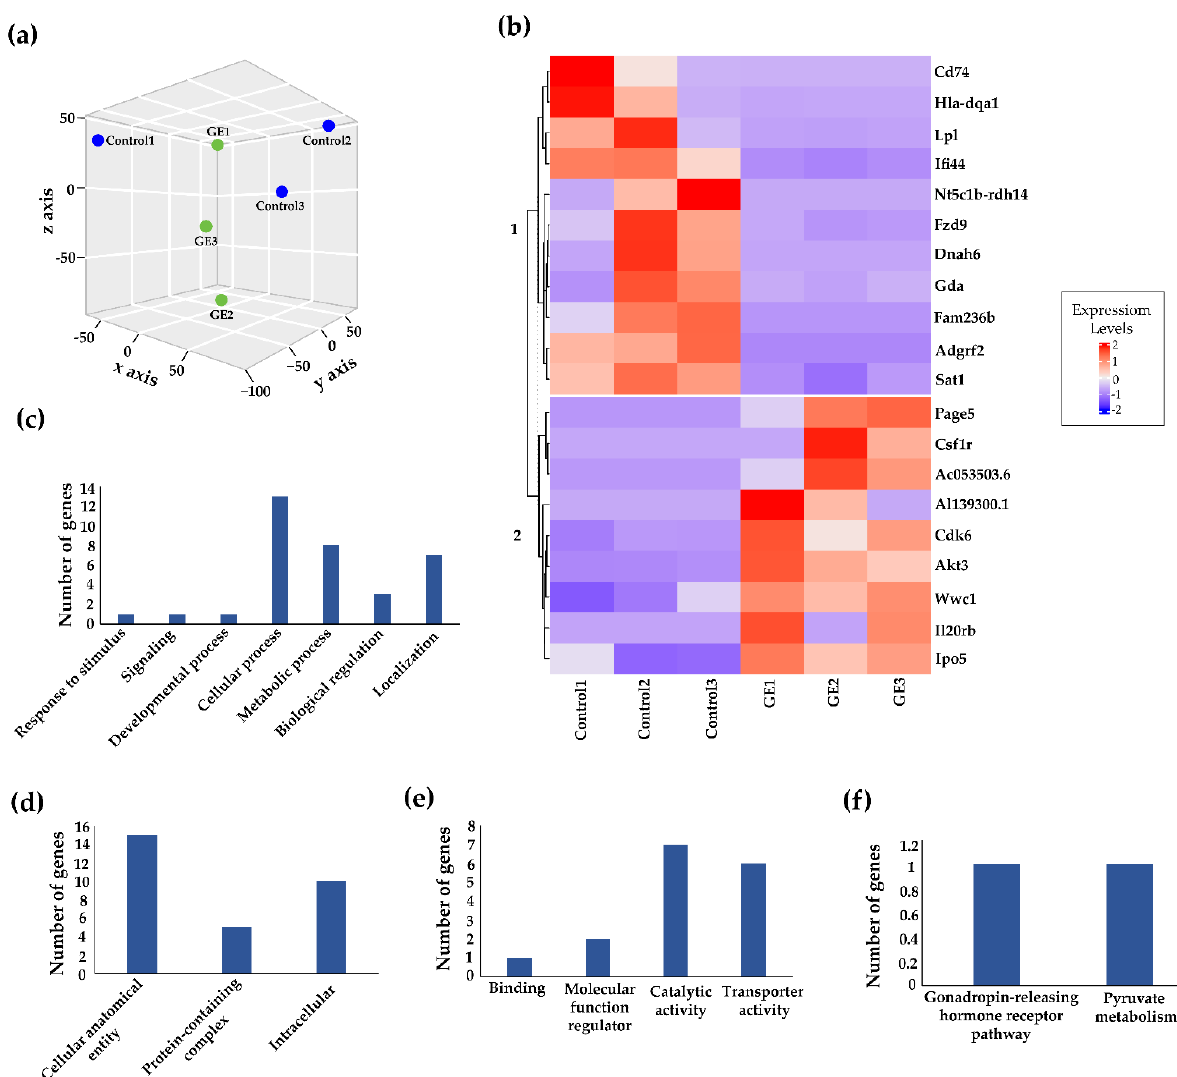
Figure 3. Transcriptome analyses and distribution of GO slim terms across dietary treatment groups. ( a ) 3-D PCoA plot demonstrates spatial arrangements of each sample from control and GE treatment groups. ( b ) Heatmap represents nine upregulated and eleven downregulated genes induced by dietary GE based on p value. Each row corresponds to differentially expressed transcripts and each column represents biological replicates in control ( n = 3) and GE ( n = 3) treatment group. Purple color denotes lower expression levels and red color denotes higher expression levels. Bar plot distribution of GO slim terms of differentially expressed transcripts related to the dietary GE treatment in ( c ) biological process, ( d ) cellular components, ( e ) molecular functions and ( f ) pathways. The column of bar plot represents the total number of differentially expressed genes. Table 1. The top DEGs in response to dietary soybean GE treatment assorted by p value.